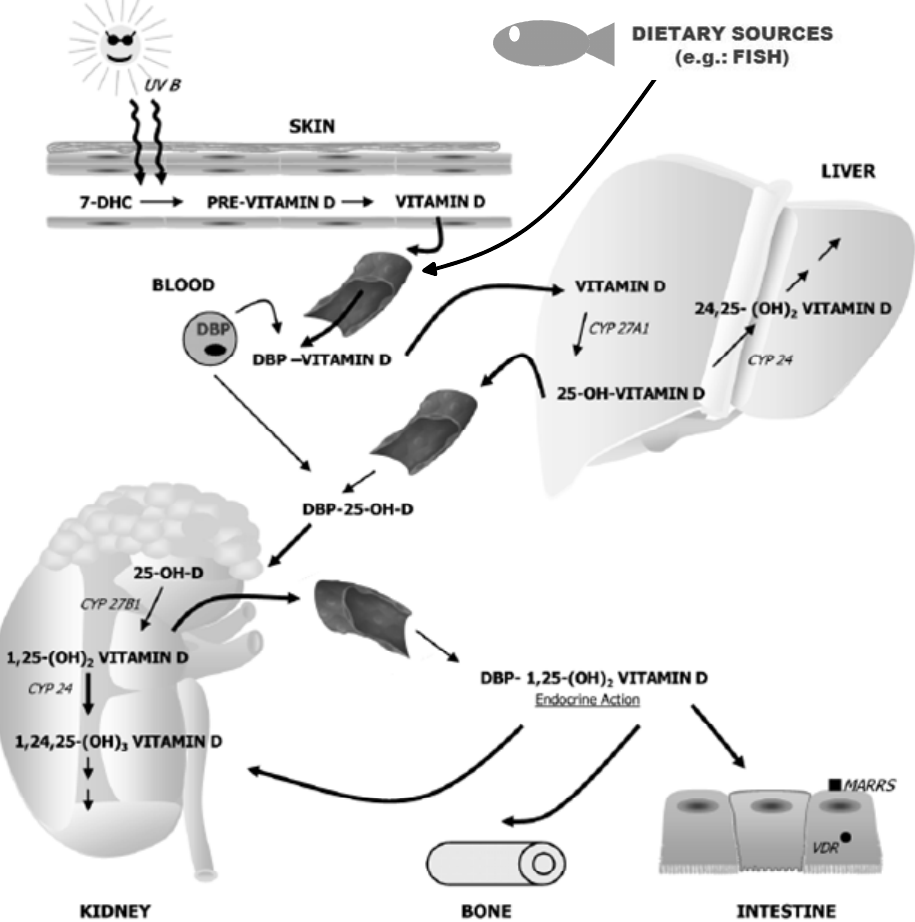
or CYP27A1) to 25-hydroxyvitamin D (calcidiol), the main vitamin D form circulating in plasma and a substrate for production of the hormonally active metabolite 1,25-dihydroxyvitamin D, 1,25(OH) D 2 3 (calcitriol) [26]. Figure 1. Cutaneous synthesis and metabolism of vitamin D. In the skin, 7-dehydrocholesterol (DHC) can be converted to pre-vitamin D in response to ultraviolet B (UVB) radiation from the sun. Pre-vitamin D is then converted to vitamin D. Continued cutaneous exposure to UVB can produce various photoproducts (not shown) from both pre-vitamin D and vitamin D. Vitamin D (and other vitamin D metabolites) are carried in the blood by a 50-kD vitamin D-binding protein (DBP). Vitamin D is converted in the liver by the P450 enzyme CYP27A1 to 25-hydroxyvitamin D (25OHD), which is the major form of vitamin D found in the blood. In the kidney, another P450 enzyme, CYP27B1, adds a hydroxyl group at the C-1 position of 25OHD to form the active vitamin D hormone 1,25-dihydroxyvitamin D, or 1,25(OH) D . Both 25OHD and 1,25(OH) D are hydroxylated 2 3 2 3 at C-24 by CYP24, which initiates their inactivation and metabolic breakdown. Vitamin D receptor (VDR)-mediated gene expression in response to 1,25(OH) D occurs in many 2 3 different tissues, including classical vitamin D target organs such as intestine, bone, and kidney. The active vitamin D hormone can also stimulate very rapid changes at the plasma membrane that are mediated by a 1,25(OH) D membrane-associated rapid response steroid 2 3 hormone binding protein (MARRS). Adapted from Martini and Wood